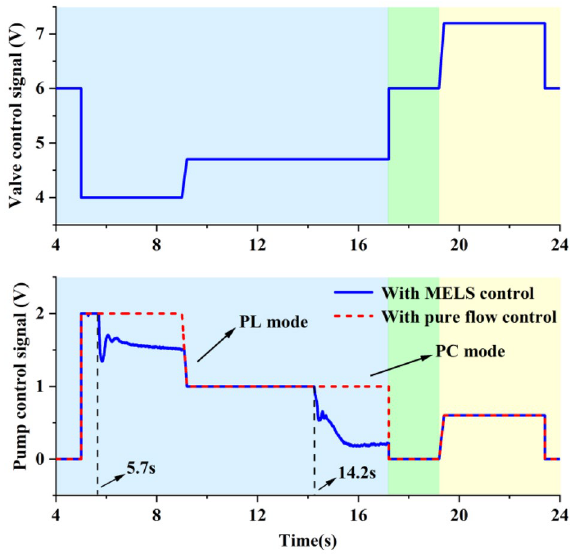
Figure 10 Control signals of the valve and pump